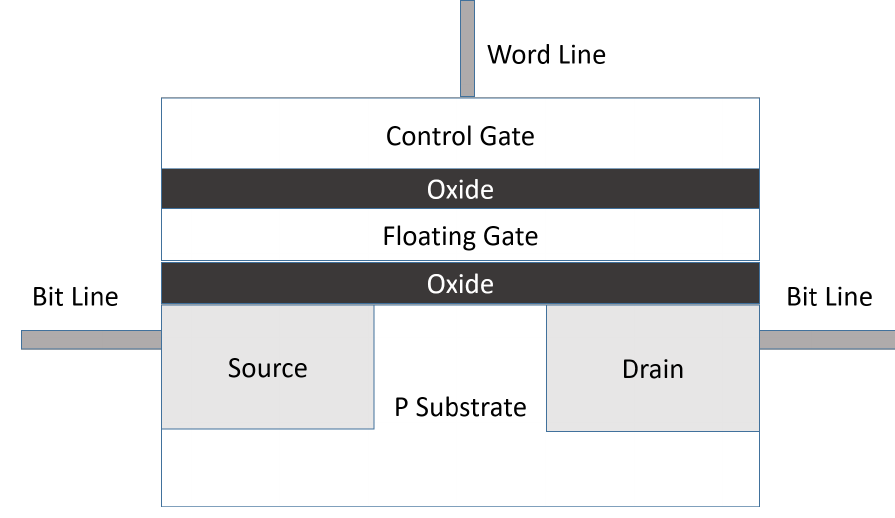
Figure 1. The structure of an NAND flash memory